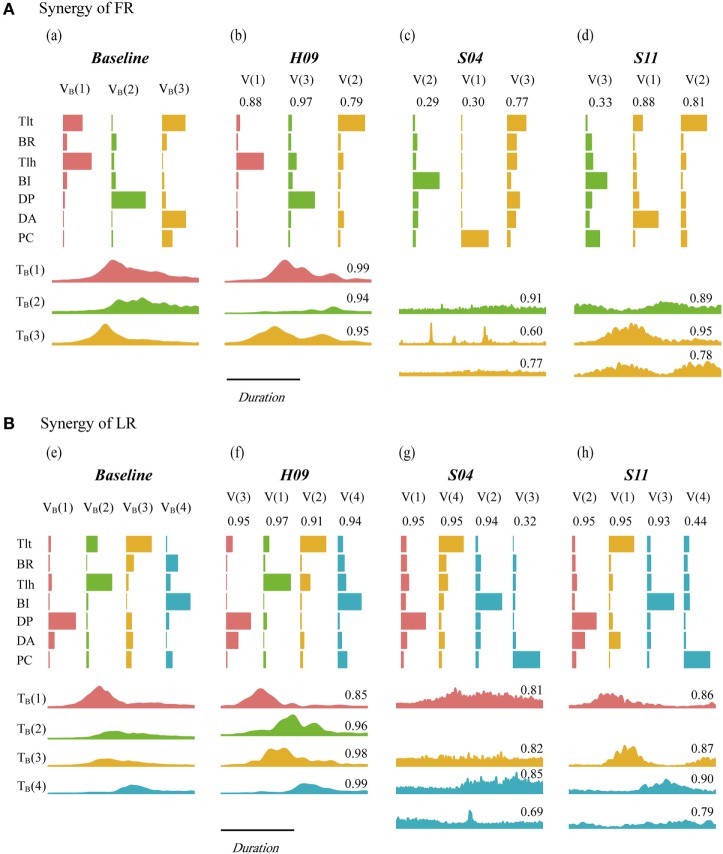
Synergy of baseline pattern, H09, S04, and S11 in forward reaching (FR) (A) and lateral reaching (LR) (B). VB and TB are the vector component and time profile of the baseline synergy from the nine control subjects of the control group. V and T are the vector component and time profile from individual subject. Paired synergy vectors were plotted with same color for each task, the corresponding time profiles were presented successively under vector plots within each subject. The value on top of each vector and time profile indicates the value of closeness of individual vector and time profile.